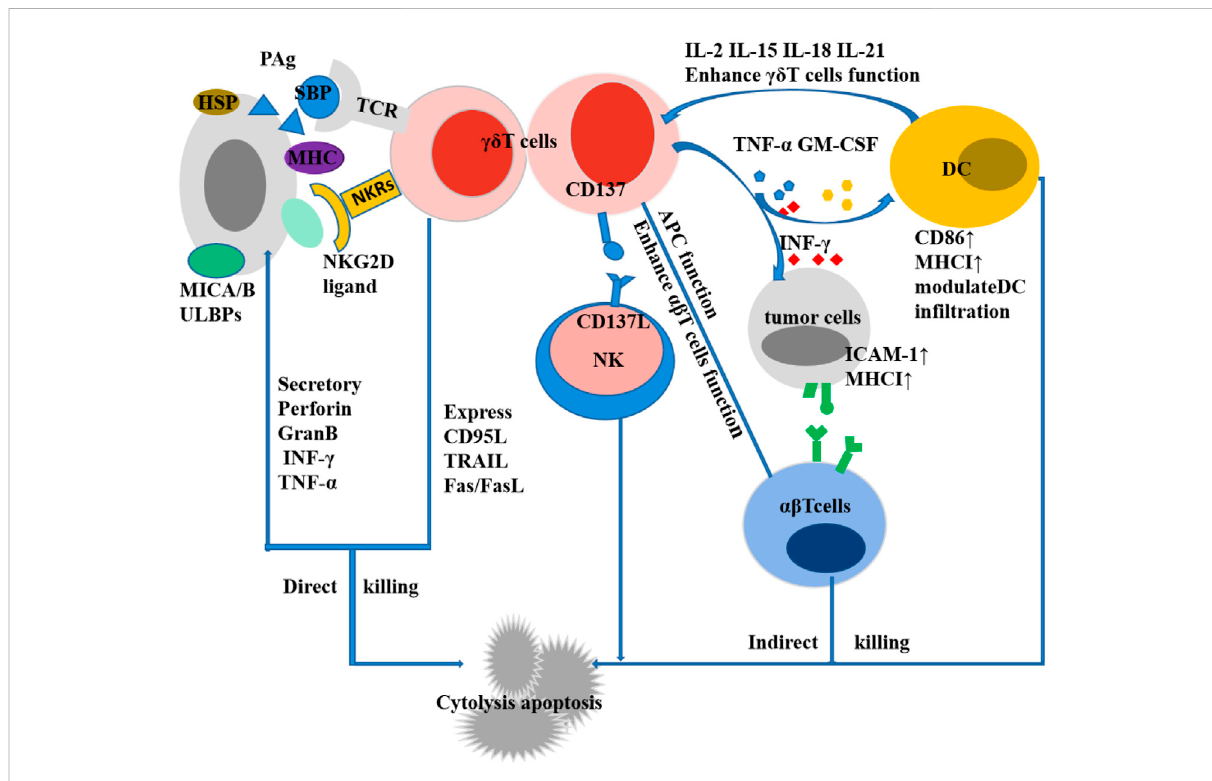
FIGURE 2 Anti-tumor effect of γδ T